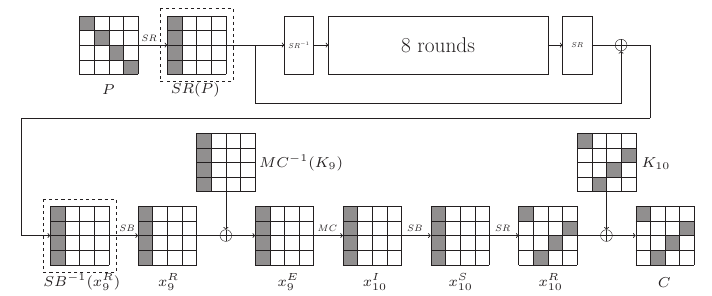
Figure 12: Zero-correlation attack for Dual-AES-PRF 8 , 2